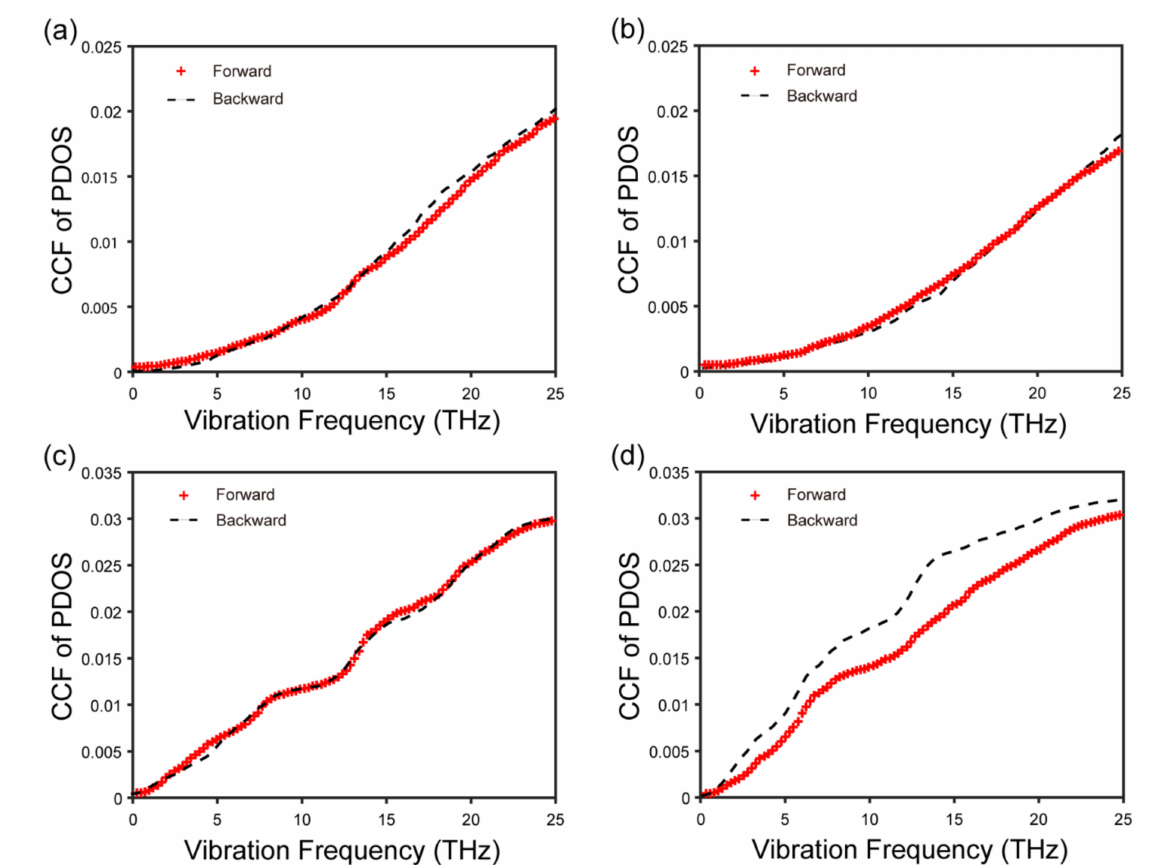
Figure 3. CCF of PDOS between C and BN atoms in the forward and backward direction. ( a ) In-plane direction in the middle; ( b ) in-plane direction at the interface; ( c ) out-of-plane direction in the middle; ( d ) out-of-plane direction at the